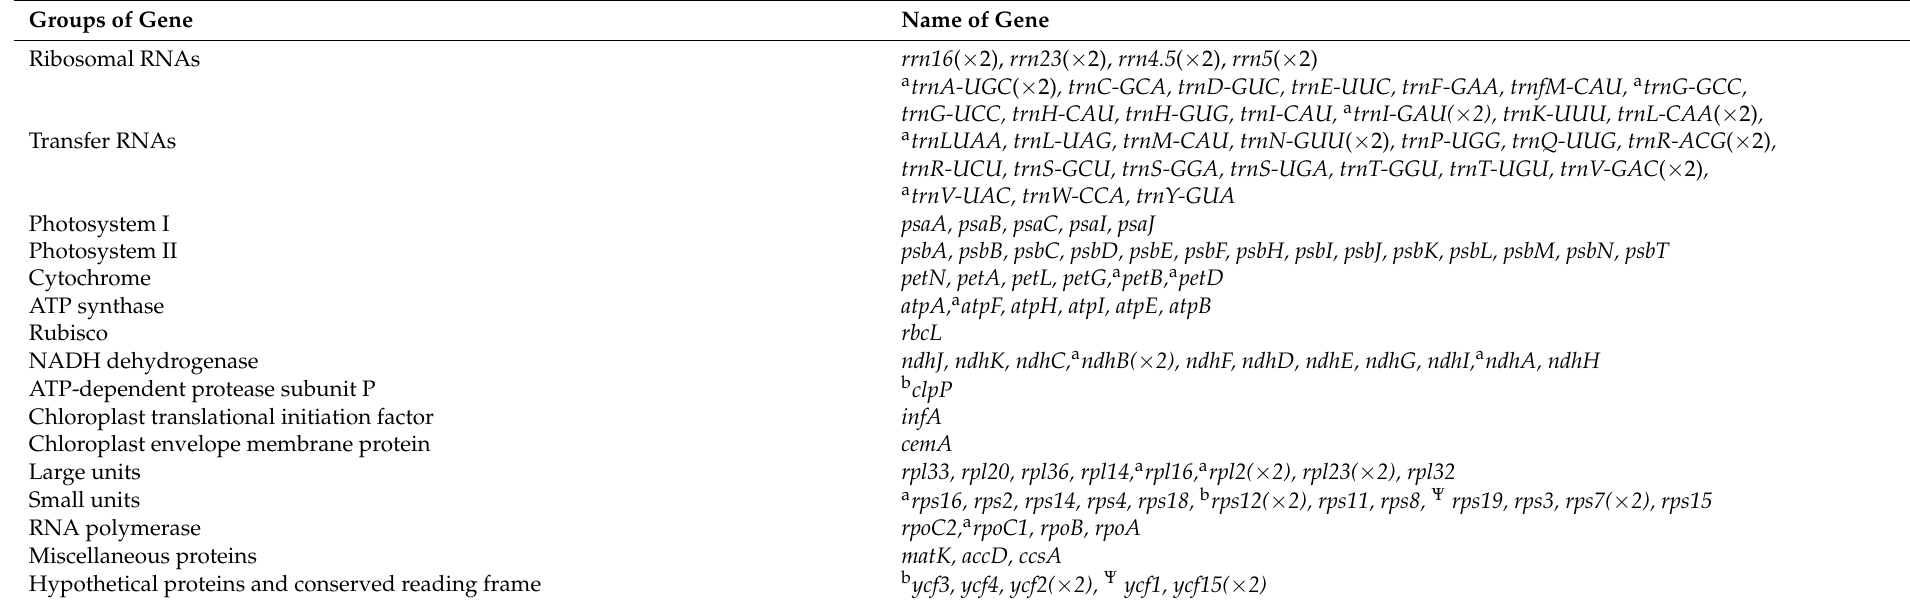
Table 2. Gene composition of Scrophularia chloroplast